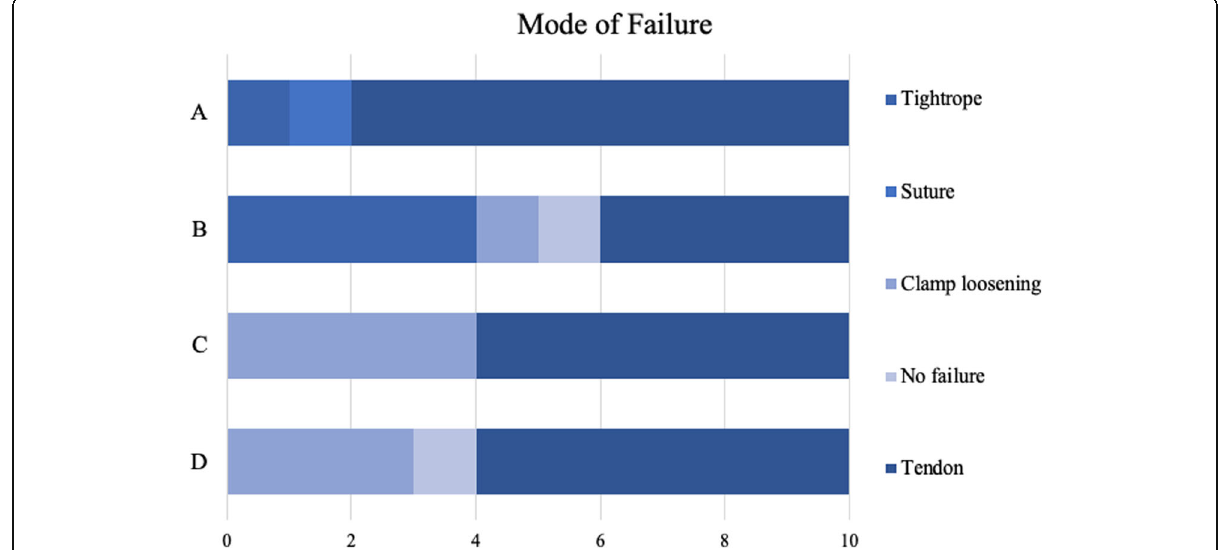
Fig. 3 Graphic view of mode of failure per group. In group A no clamp was used. For group C and D only clamp loosening and tendon